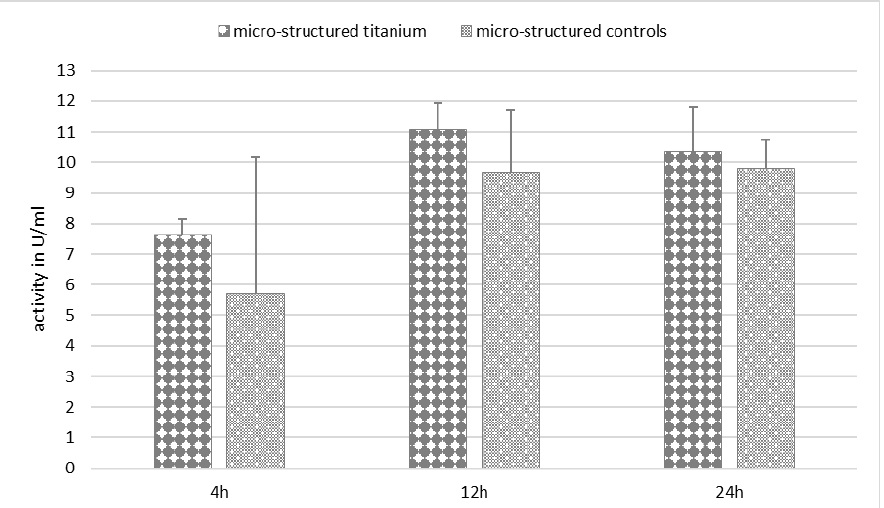
Figure A2. Comparison of alkaline phosphatase activity after 4, 12, 24 h between microstructured titanium samples and controls. The bars correspond to the mean value, the line on top to the ± standard deviation.